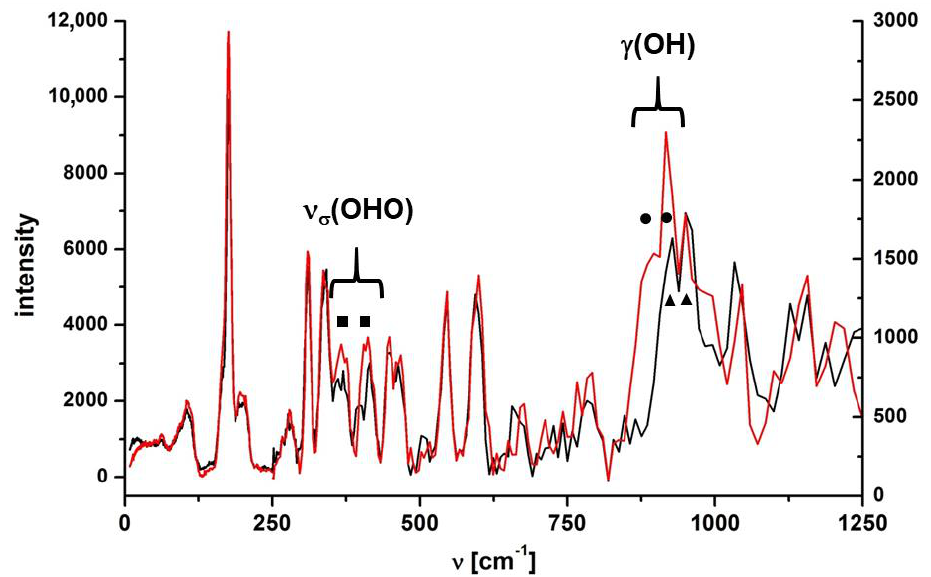
Figure 5. IINS spectra of CNK polymorph I (red line) and its deuterated analogue (black line). The IINS spectra were aligned and normalized in 0–250 cm –1 and 250–1250 cm –1 regions, separately.